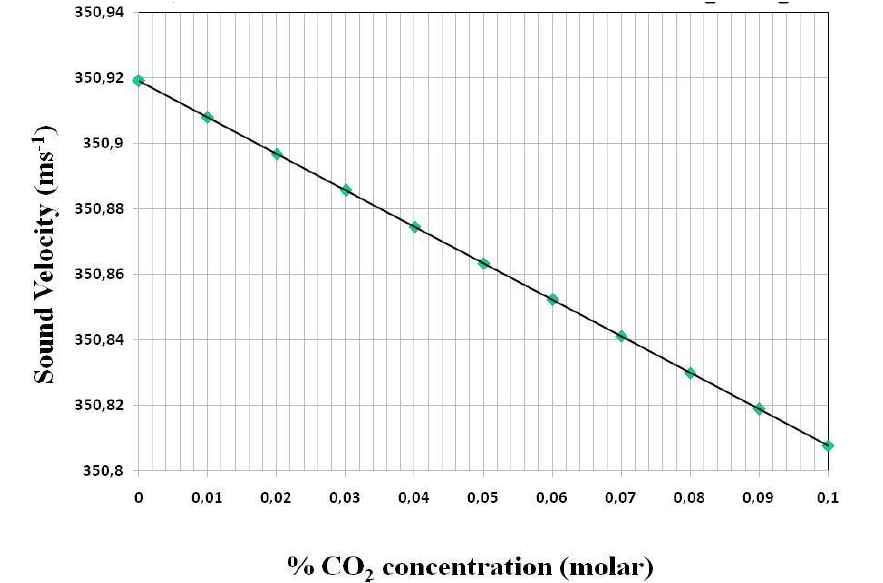
) at 1bar and a 2 abs